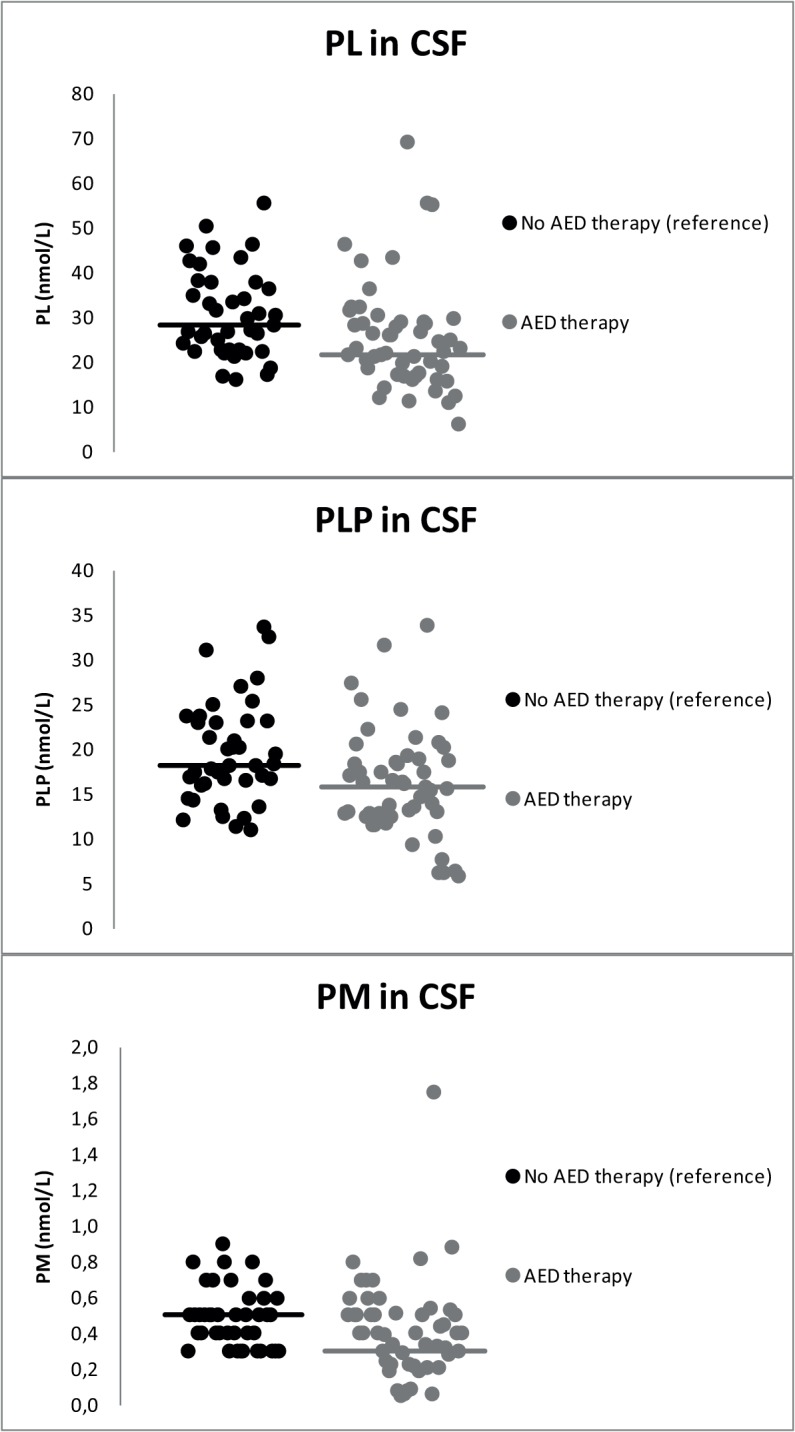
Concentrations of PL, PLP and PM in CSF of children using one or more AEDs (n = 51; from both the original and additional sets) compared to children not using any AEDs (n = 41).Median concentrations of PL, PLP and PM were lower in CSF of children with AED-treated epilepsy than in CSF of children not using any AEDs.